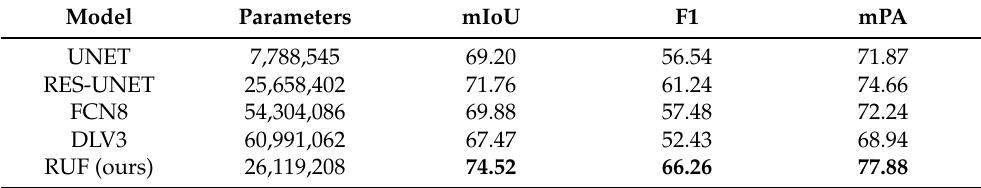
Figure 8. Comparison between the predictions of FCN-8, DeepLabV3, and RUF for the task of ice floe segmentation on patches from the test set. Red ovals highlight segmentation results where both FCN and DLV3 are unable to properly segment a fully or partially visible ice floe. Green ovals highlight segmentation results where both FCN and DLV3 are unable to delineate floes in close proximity. It can be observed that the proposed RUF architecture is able to produce finer segmentation results compared to the other frequently used segmentation methods in satellite imaging on our dataset. Here, Patch and GT denote original image patch input and ground truth, respectively. The sea ice concentration (SIC) masks are overlaid on the respective patches for comparison between sea ice as continuous (passive microwave data) vs. discrete (processed ice floe masks from SAR) information. Table 7. Comparison between various segmentation architectures on test set. Best results are in